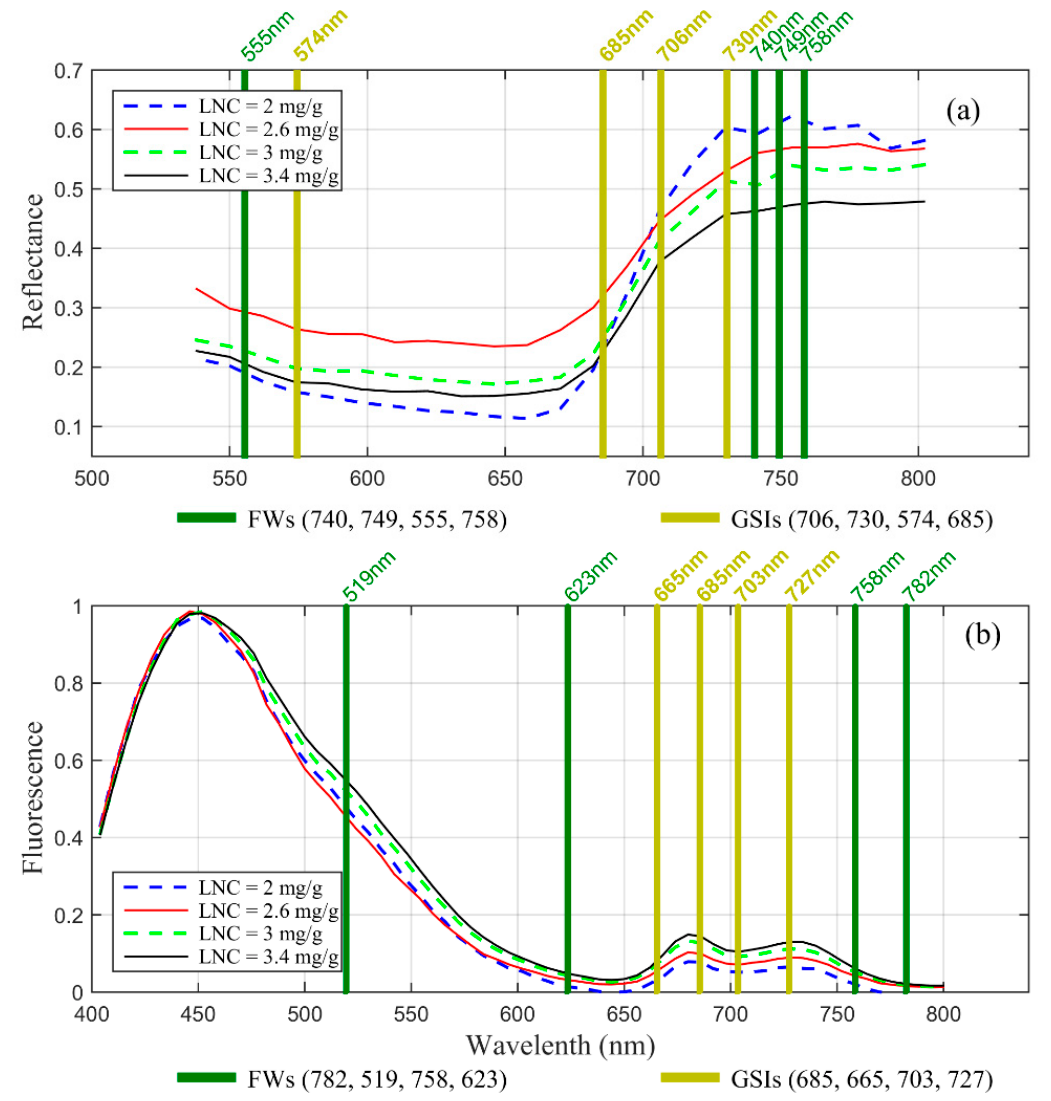
Figure 2. Spectra of S r and S f collected with ( a ) Hyperspectral LiDAR and ( b ) laser-induced fluorescence LiDAR system under different rice LNCs. Stripes on S r and S f curves represent prior band distribution ranked based on the FW and GSI values, which will be discussed in the Results section.